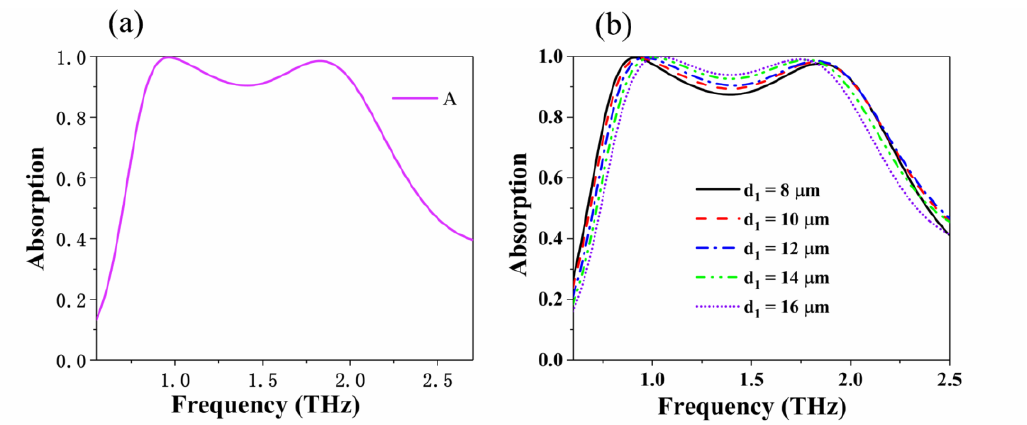
Figure 8. ( a ) Absorption spectrum of a proposed double-layer graphene absorber. ( b ) Absorption spectrum of the proposed double-layer graphene interlayer thickness d 1 .